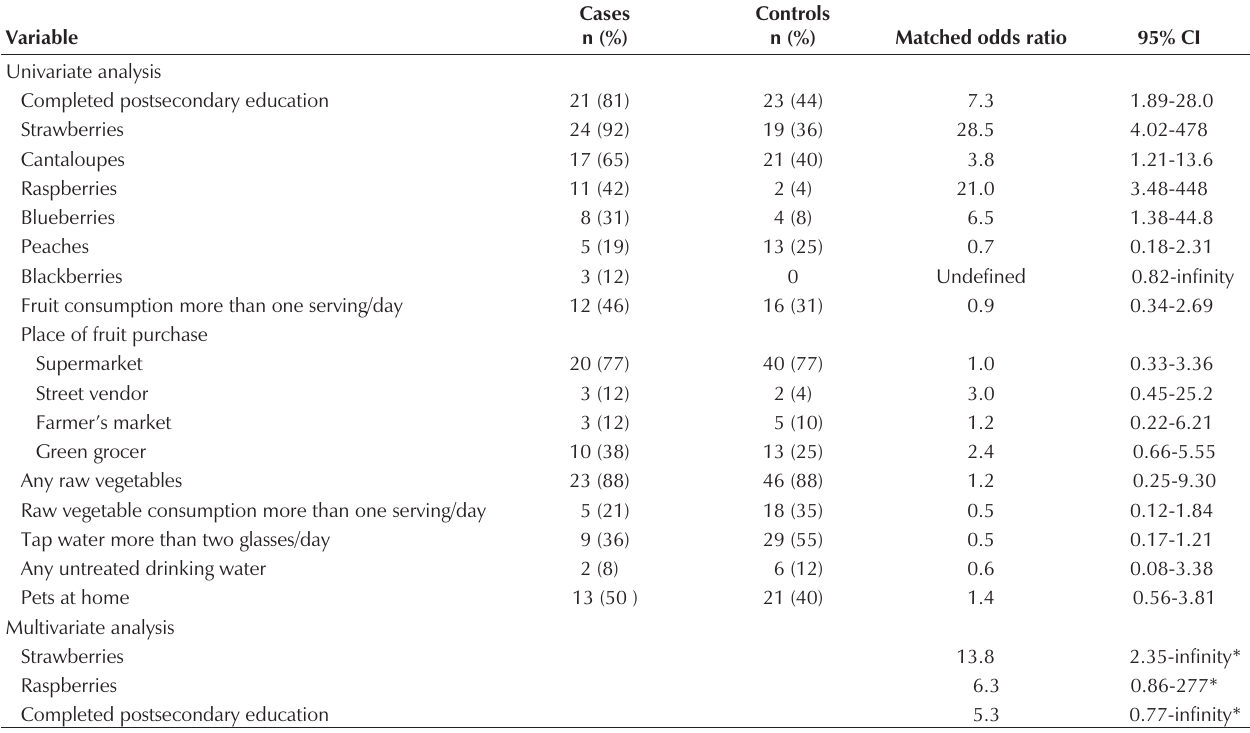
TABLE 3 Results of the matched case-control study (cases 26; controls 52) in an outbreak of cyclosporiasis in Ontario in 1996 Variable